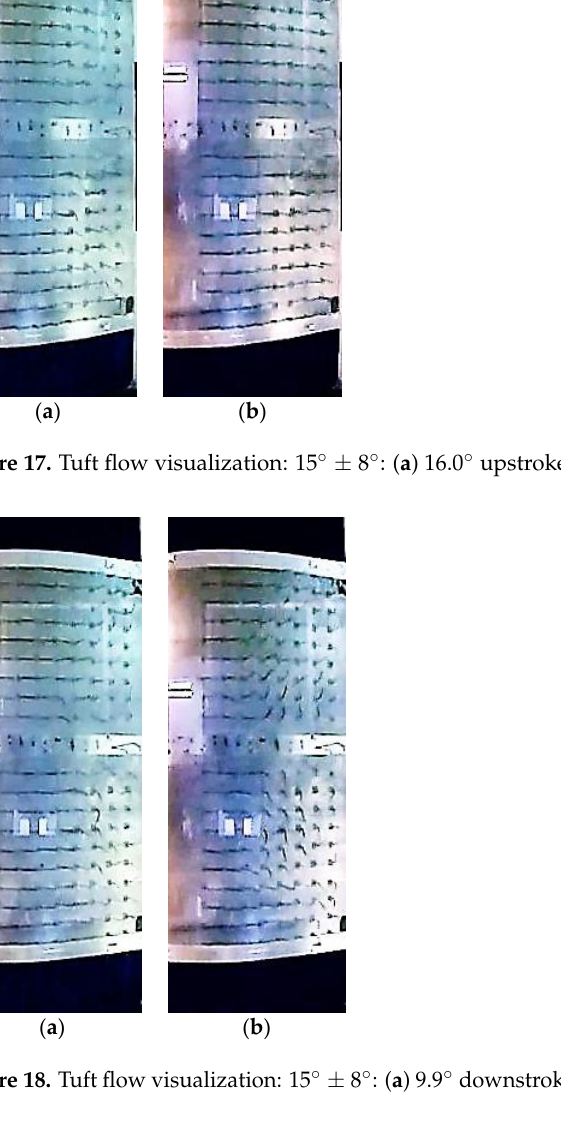
Figure 19. Energy coefficient variation in a cycle for various mean angles of attack, two reduced frequencies (0.1 and 0.2) and Re = 0.5 × 10 5 . Mean angle of attack (from left to right): α m = 0°, α m = 5°, α m = 10°, α m = 15°. For the case of a single degree-of-freedom harmonically pitching airfoil, the cycle aerodynamic damping coefficient Ξ , as defined by Carta and Niebanck [27] and Oates [28], is: